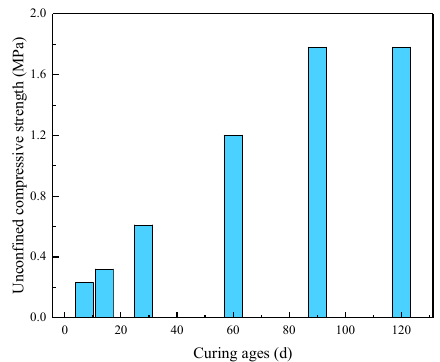
Figure 2. The development of unconfined compressive strength of the phosphogypsum (PG)-based backfill specimens within 120 days.